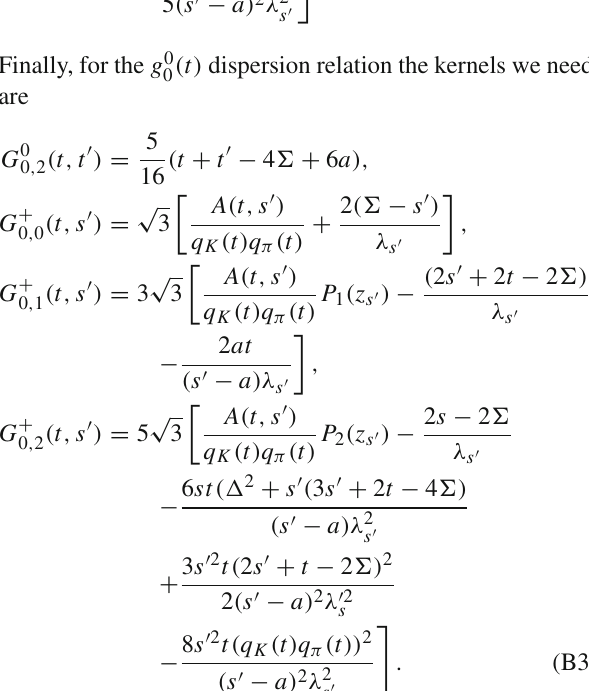
sponds to the angular momentum of the partial-wave dis- persion relation, i.e. the “output” partial wave, whereas (cid:7) (cid:5) corresponds to the angular momentum of the “input” wave in the integrand of the dispersion relation. Similarly, s (cid:5)